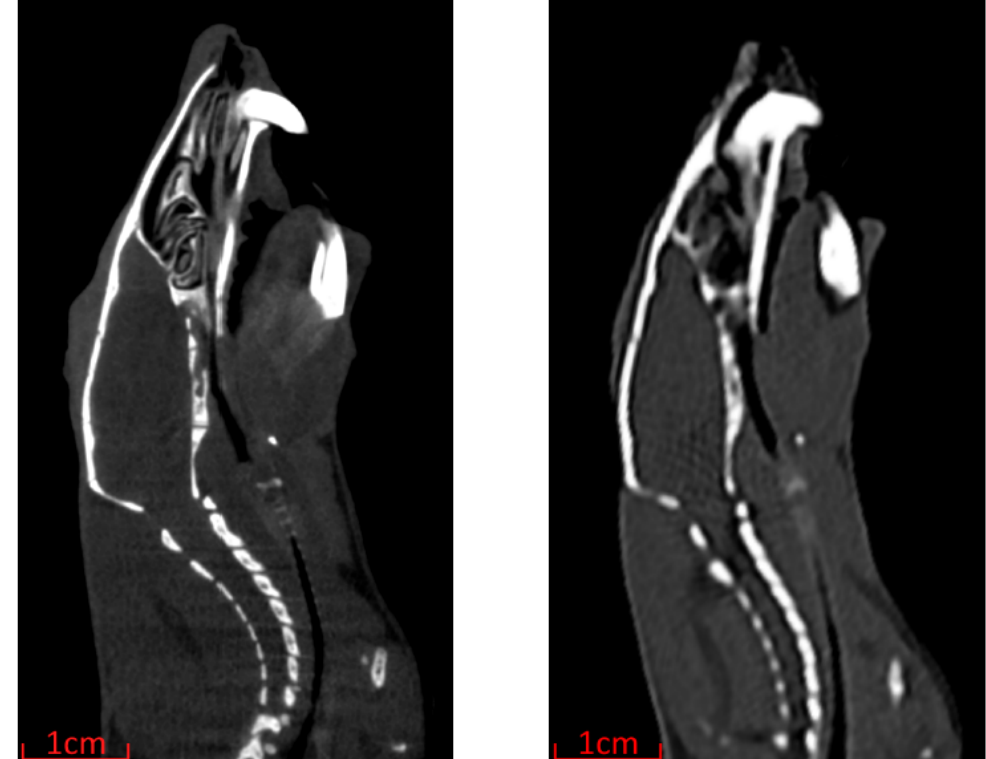
Figure 4. Sagittal reconstruction of rat comparing CT scan image quality. Inveon Multimodality System with 97µm × 97µm × 97µm voxel resolution ( left ) and Siemens SOMATOM go.Up with 300µm × 300µm × 300µm voxel resolution ( right